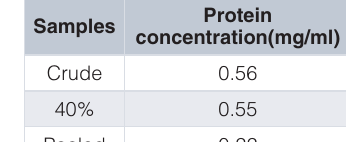
Table 1. Total protein content in different stages of purification.